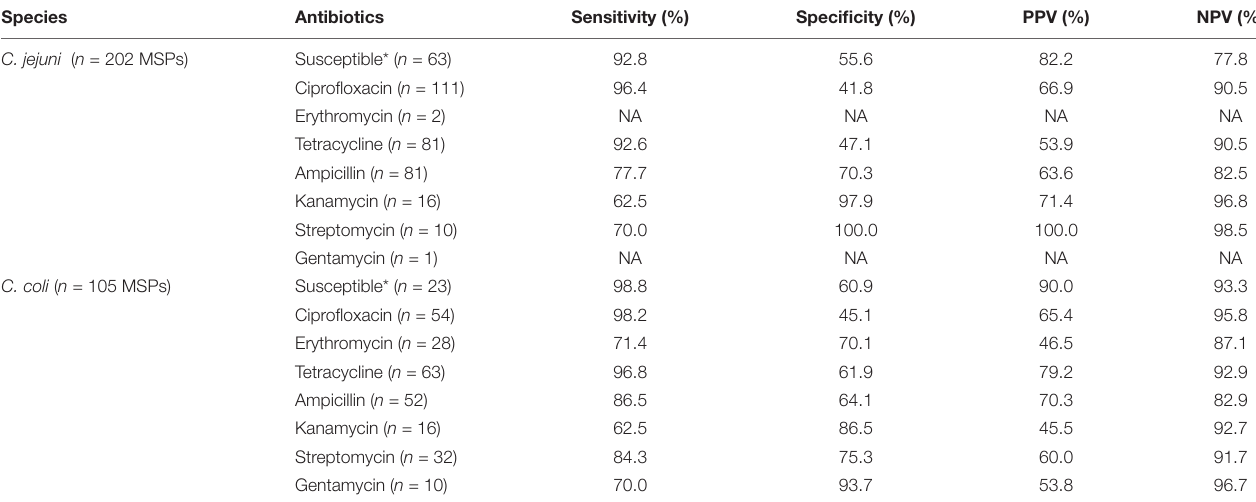
TABLE 3 | Performance of retained machine learning classifier using C. jejuni (n = 202 MSPs ) and C. coli ( n = 105 MSPs) MALDI-TOF main protein spectra profiles (MSPs) of the test set (30%), grouped by the resistance profile.